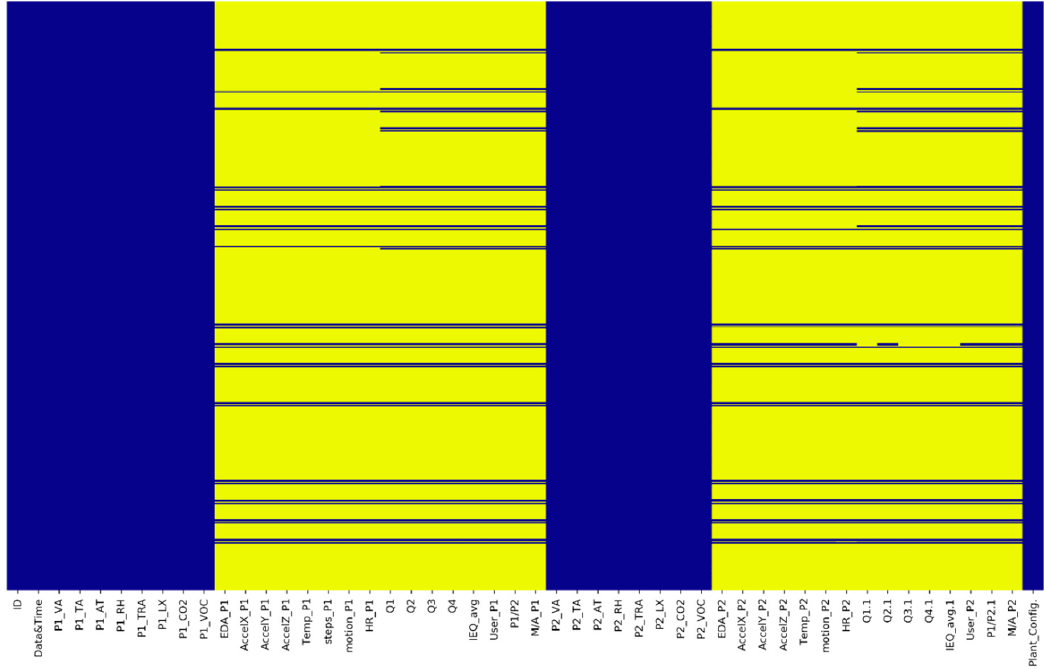
Figure 4. Starting dataset and related parameters: in yellow – null data, in blue – non-null data.